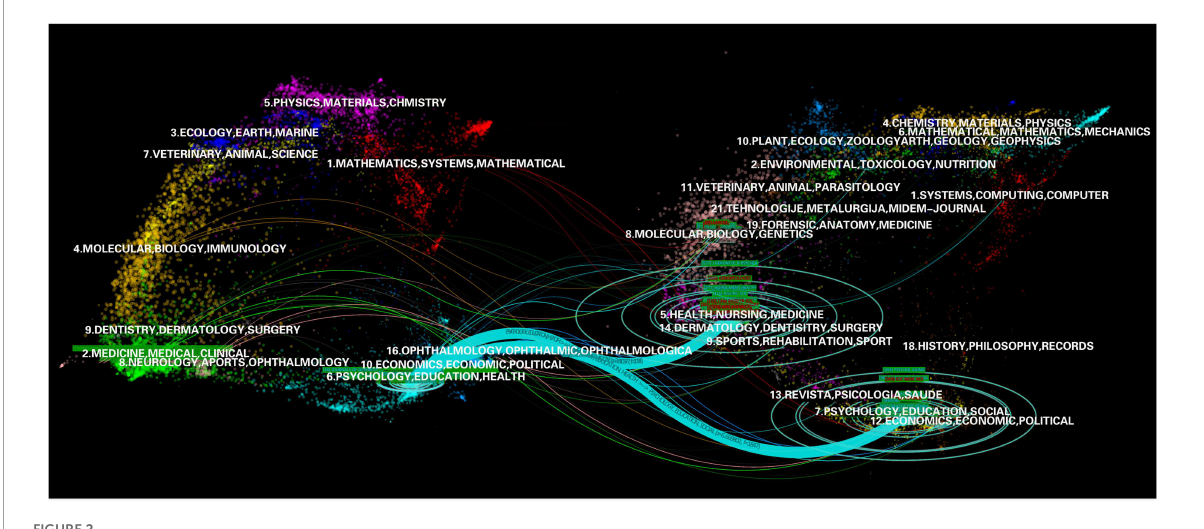
FIGURE2 Dual map overlay of journals publishing research on the SWB in older adults. Citing journals are on the left, cited journals are on the right, and the colored paths between them indicate the citation relationship.